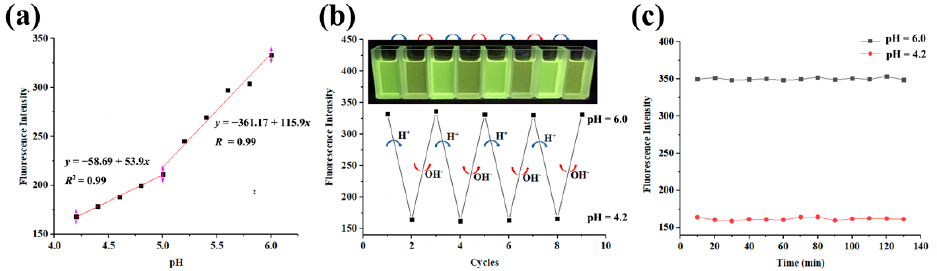
Figure 2. ( a ) The linear responses of fluorescence intensity. ( b ) Reversibility of the fluorescence intensity of MMN between apparent pH 4.2 and 6.0. Inset: The color changes of MMN solution under UV light of 365 nm. ( c ) Changes in the fluorescence intensities of MMN with times among nonacidic and acid conditions.